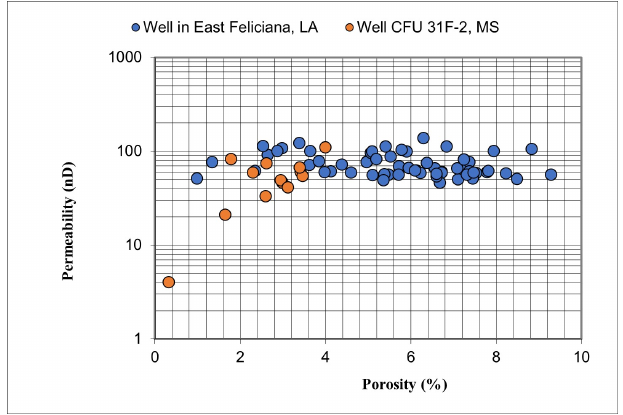
Figure 5. Plot showing permeability versus porosity estimates for samples acquired from a well in the East Feliciana Parish, LA (data points in blue), and Well CFU 31F-2 in Cranfield field, MS (data points in orange).